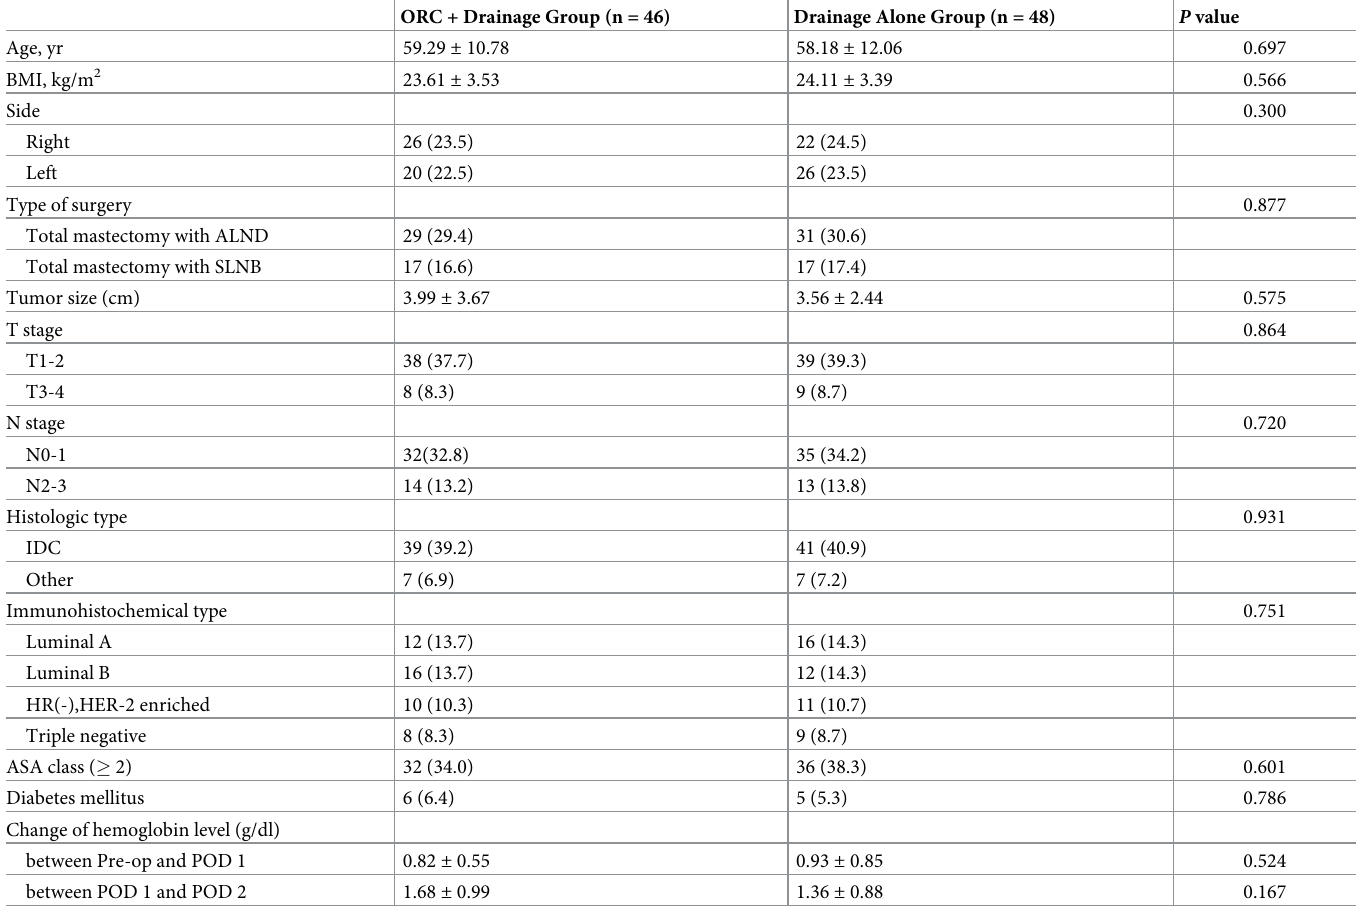
Table 1. Baseline demographic and clinical characteristics of included